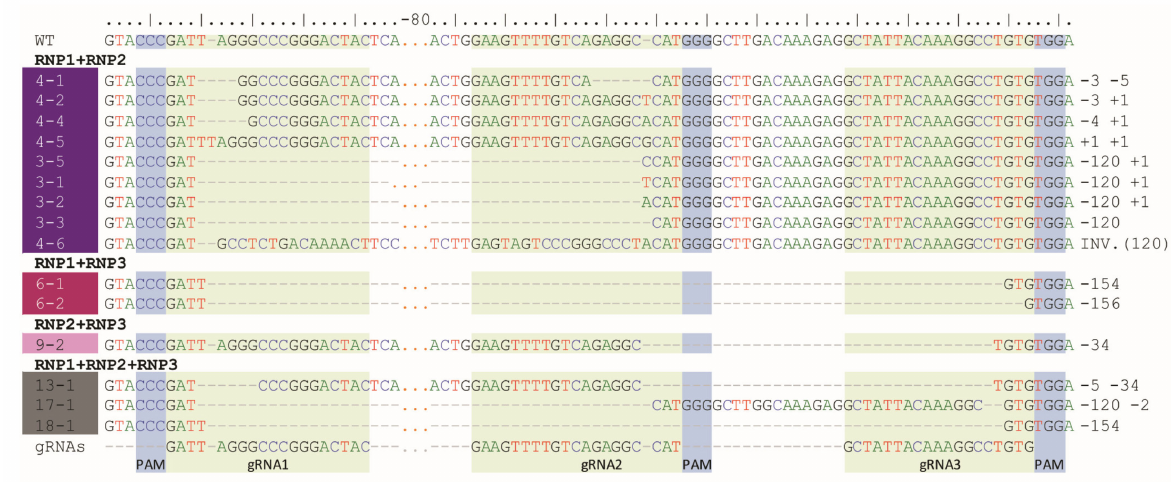
Figure 4. Example mutant variants of the F3H gene aligned to WT and gRNA sequences and obtained after RNPs delivery in pairs or in